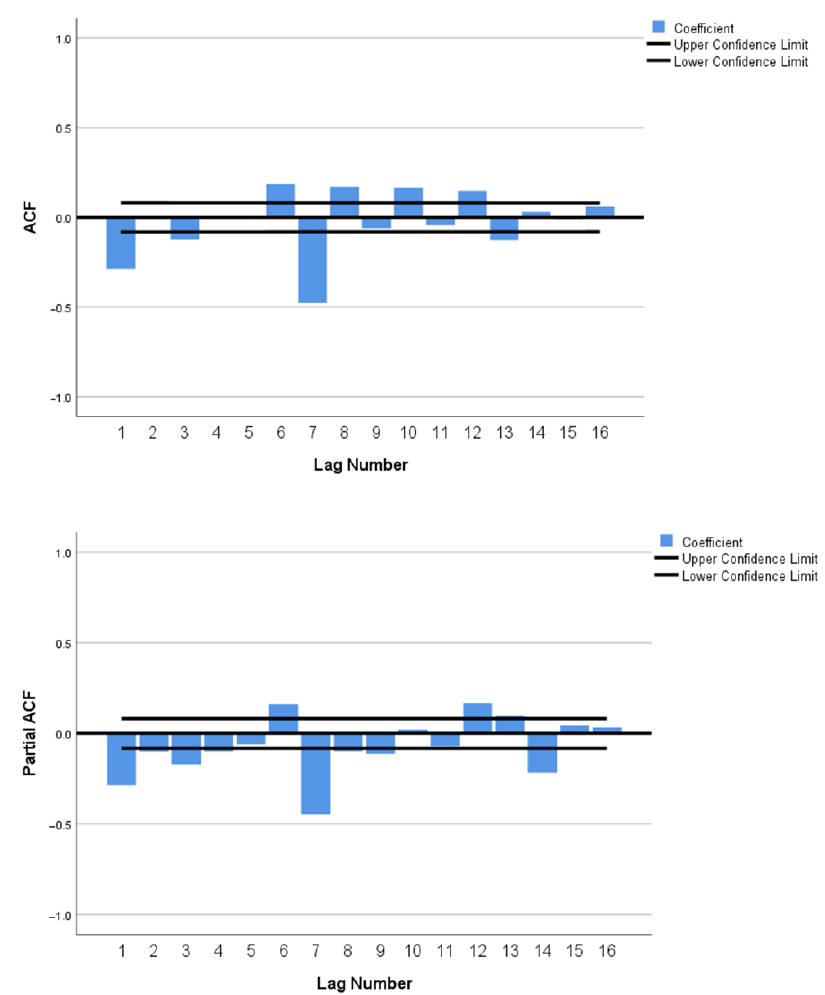
Figure 1. ACF plots and PACF plots with two-degree differencing.